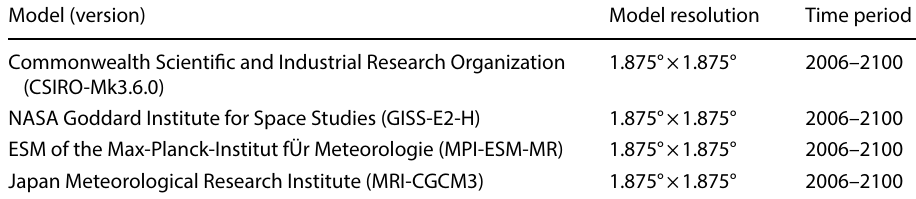
Table 1 Global Climate Models (GCMs) that were used in